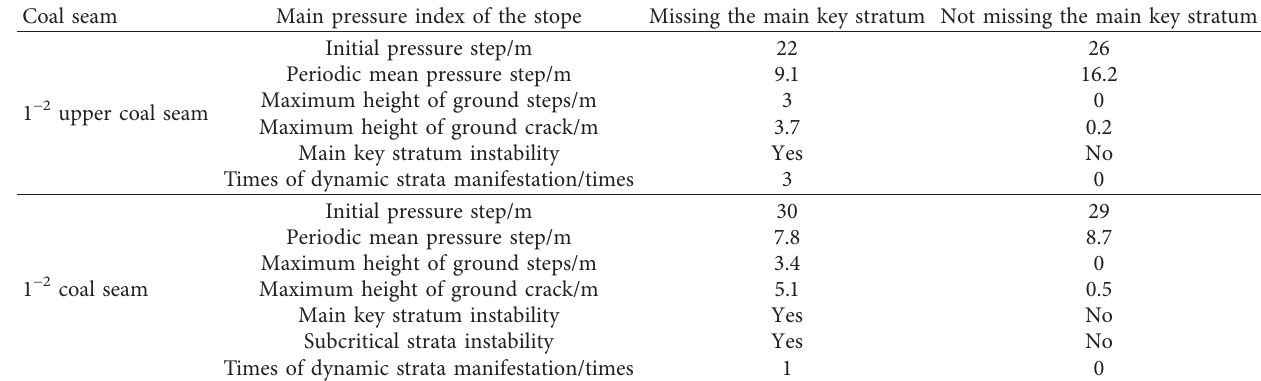
Table 5: Effect of absent/present strata on the stress of the main key stratum. Coal